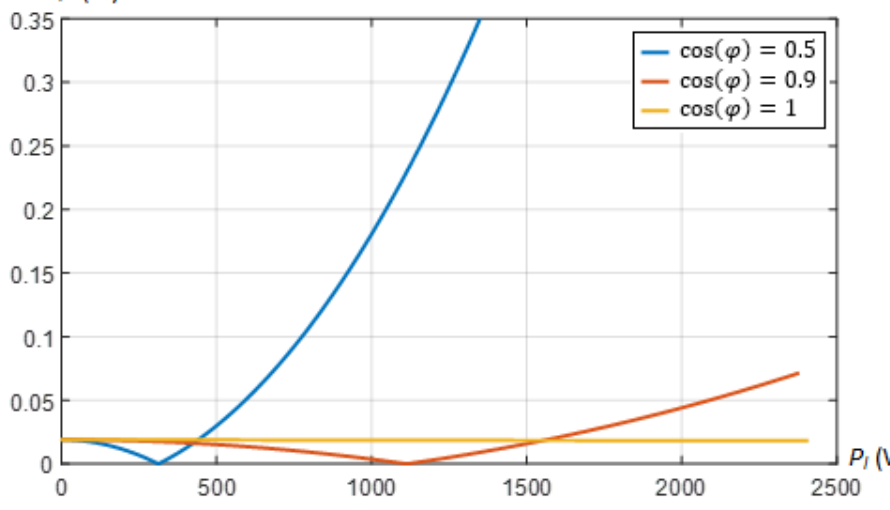
Figure 12. Dependence of the error on load power and power factor.